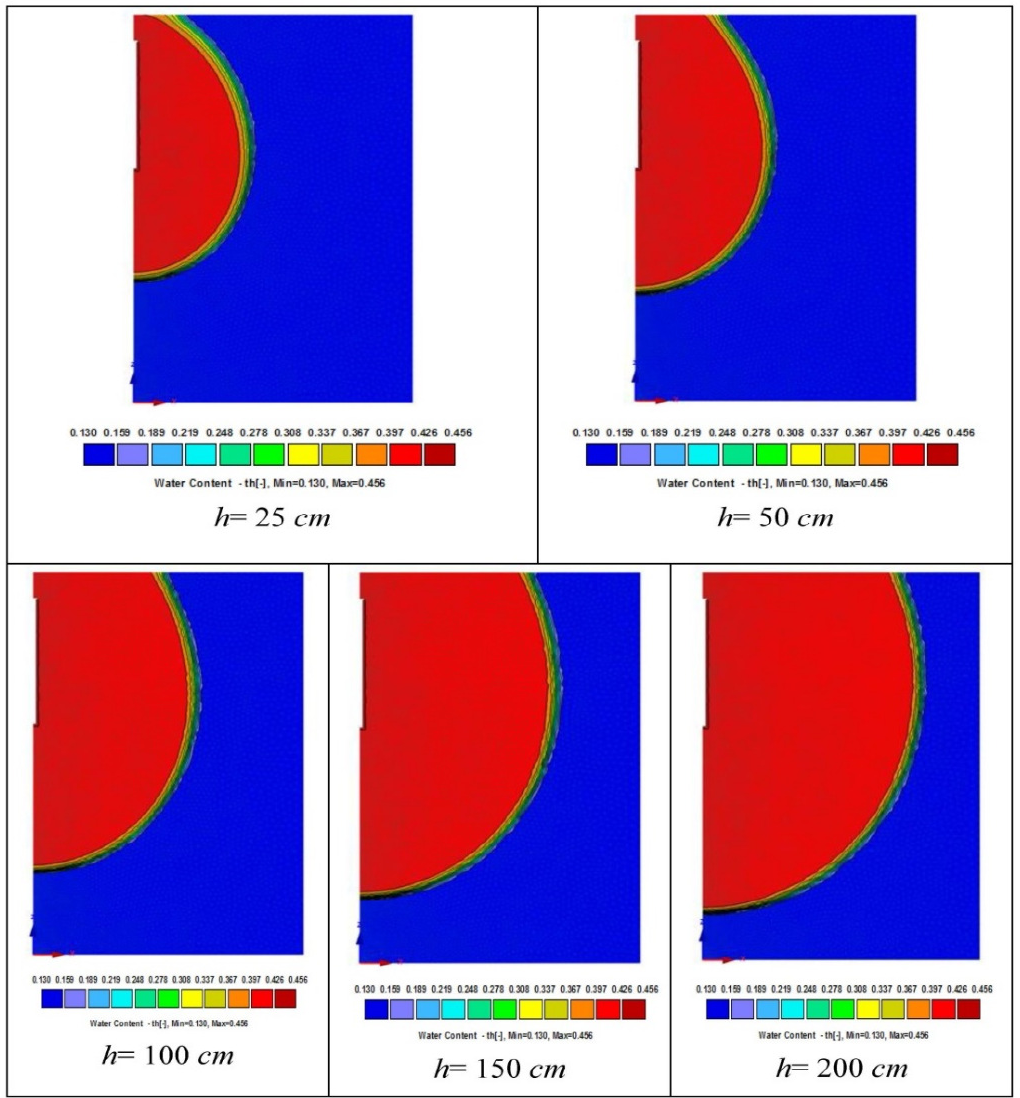
Fig. 3. Simulation of wetting patterns from a ceramic pipe in sandy loam soil with 1.0 x 1.5 m domain, pipe length= 50 cm, pipe hydraulic conductivity= 0. 3 cm/hr, initial soil water content= 0.13 cm 3 /cm 3 , and with different applied heads after 1.5